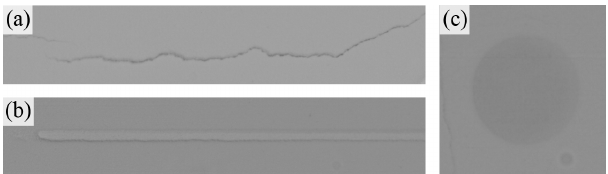
Figure 9. Difficulties for edge detection: (a) insufficient powder adhesion, (b) scoring caused by powder application system, and (c) low contrast between melting pool and powder bed (especially after powder application).